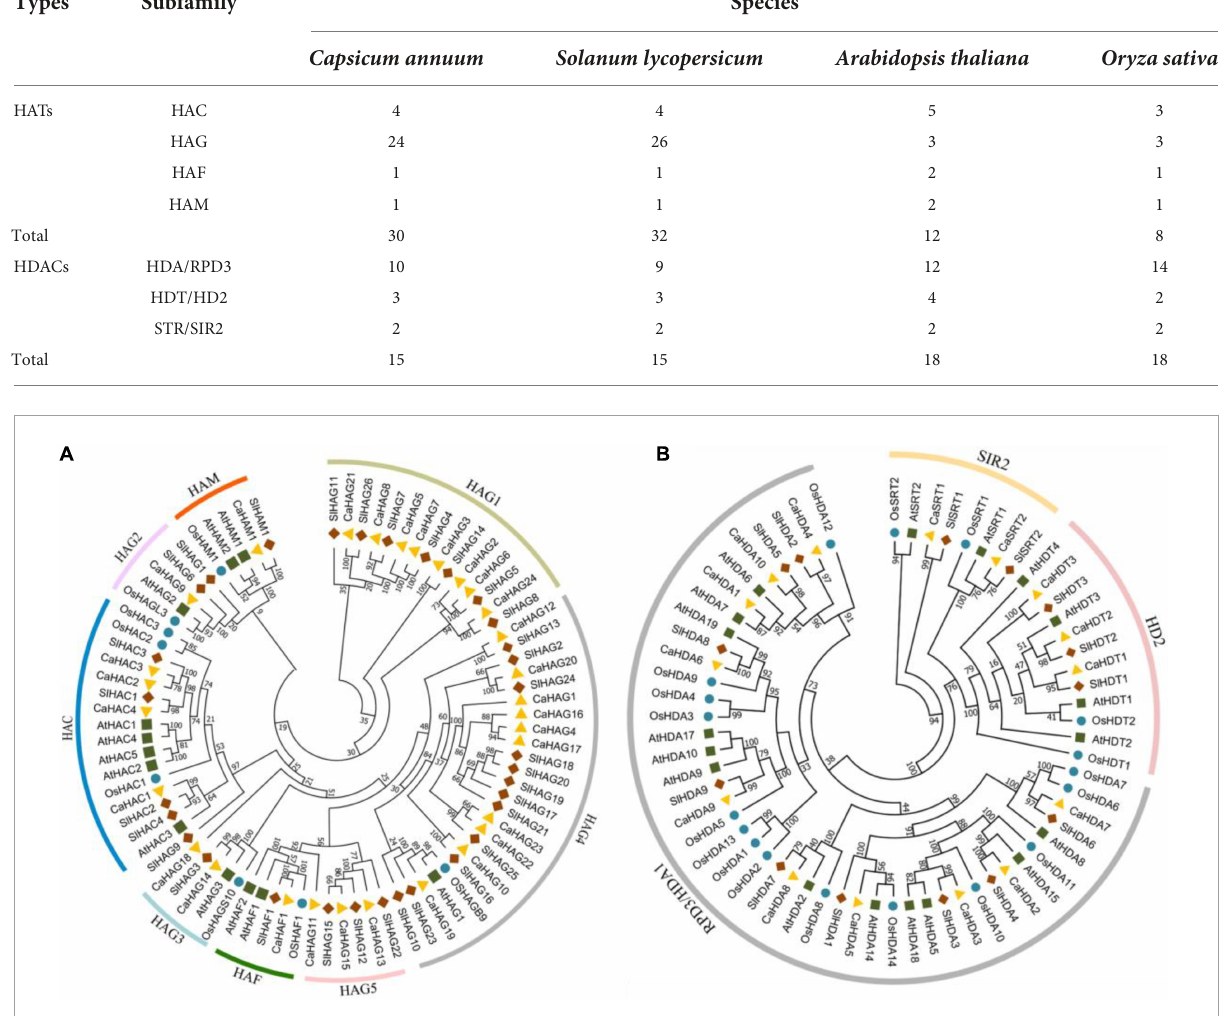
FIGURE8 Phylogenetic tree of the HAT and HDAC proteins. The HAT (A) and HDAC (B) proteins of pepper ( Capsicum annuum ), Arabidopsis ( Arabidopsis thaliana ), tomato ( Solanum lycopersicum ), and rice ( Oryza sativa ) were adopted for analysis. The tree was constructed with the maximum likelihood method by adopting HAT and HDAC protein full-length protein sequences from pepper ( Capsicum annuum ), Arabidopsis ( Arabidopsis thaliana ), tomato ( Solanum lycopersicum ), and rice ( Oryza sativa ). The number at each node represents the bootstrap value from 1,000 replicates. The protein sequences used in this study were retrieved from Solanaceae Genomics Network and NCBI